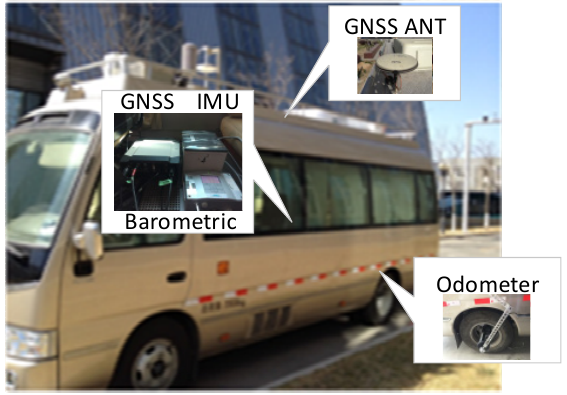
Figure 11. The test platform including GNSS receiver, IMU, barometric altimeter, and odometer.